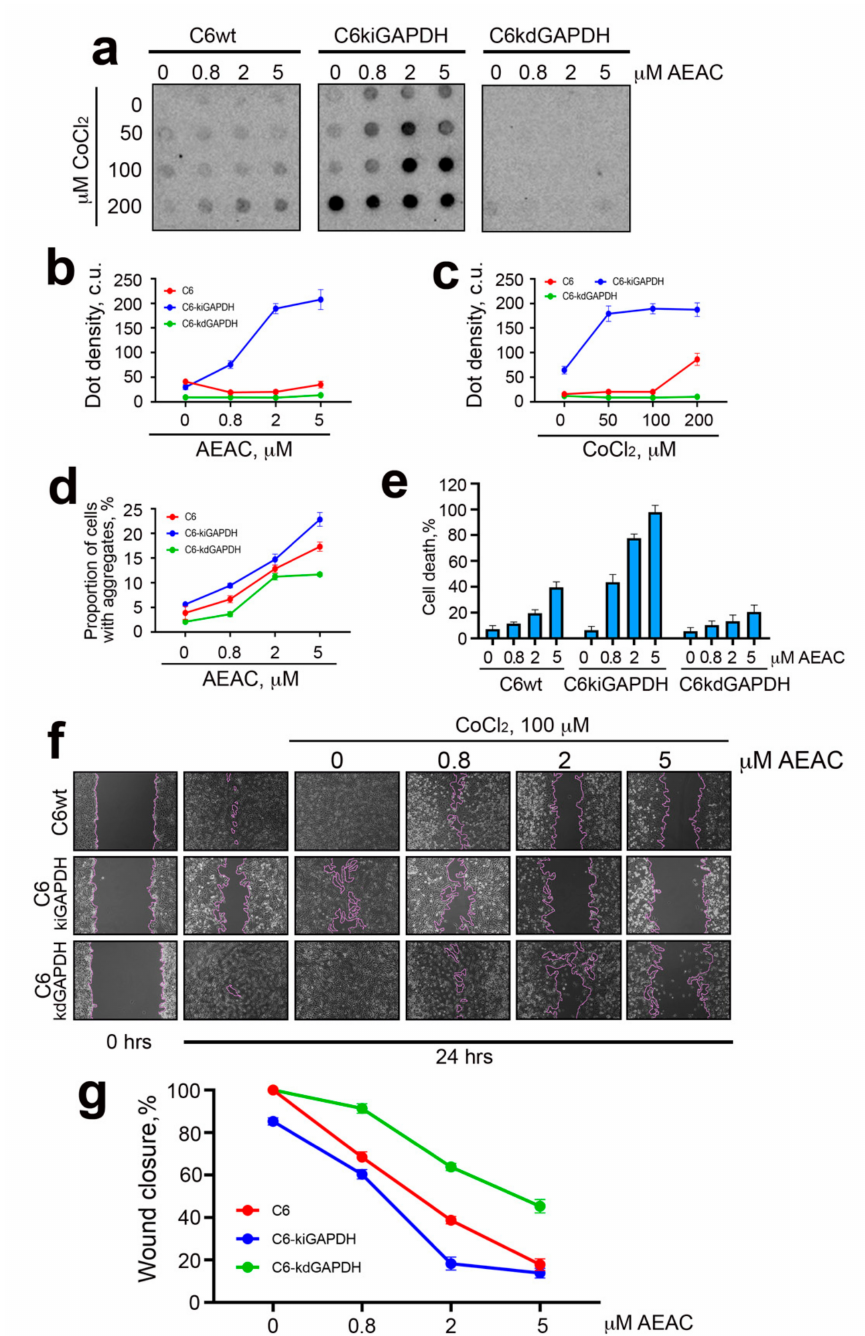
Figure 4. The level of GADPH expression affects the intensity of the enzyme aggregation, viability, and motility of cells during hypoxia. ( a ) C6 cells with various GAPDH levels were incubated with different concentrations of CoCl 2 and AEAC for 24 h, then lysed and subjected to ultrafiltration. The membrane was probed with anti-GAPDH antibodies. ( b , c ) The data of dot intensity quantification are presented. The result for cells incubated in the presence of 100 µ M CoCl 2 and different AEAC concentrations is shown in ( b ); the result for cells incubated in the presence of 2 µ M AEAC and different CoCl 2 concentrations is shown in ( c ). ( d ) The proportion of cells with aggregates measured with the aid of a CX7 device is presented. ( e ) The results of the CytoTox96 assay. C6 cells were incubated with 100 µ M CoCl 2 and AEAC (0.8, 2, or 5 µ M) for 24 h. ( f , g ) A wound healing assay was performed with the aid of a JuLI Stage microscope. Cells were cultivated for 24 h in the presence of 100 µ M CoCl 2 and AEAC (0.8, 2, or 5 µ M) before the monolayer was scratched. The wound healing was detected with microscopy ( f ) and quantified by JuLI software ( g